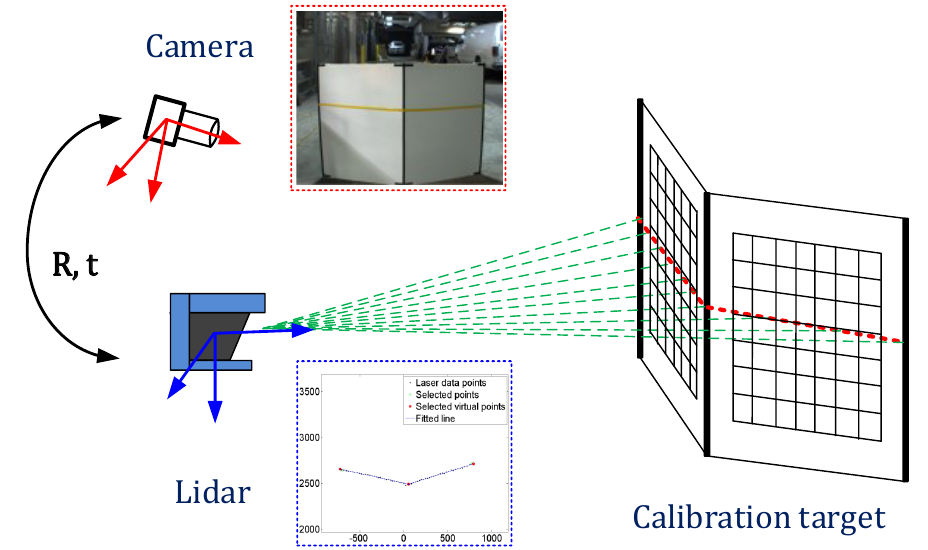
Figure 1. The relative pose between the line scanning LiDAR and the camera is estimated using features extracted from images of a v-shaped